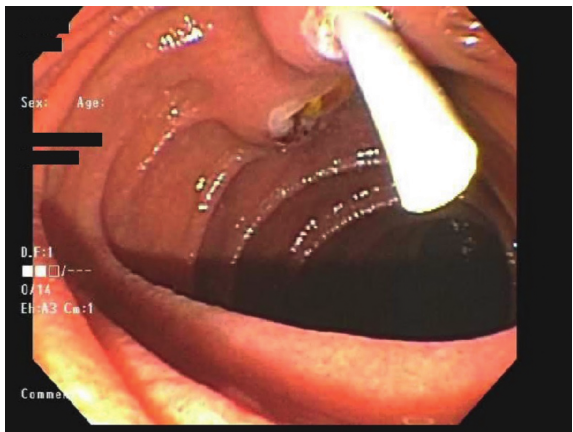
Figure 2: Plastic stent placed into the main pancreatic duct.